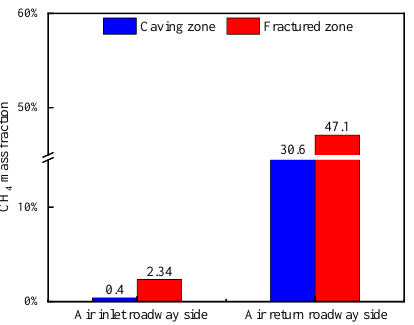
Figure 8. Comparison of influence depth of gas mass fraction in the caving zone and fracture zone in the strike direction.